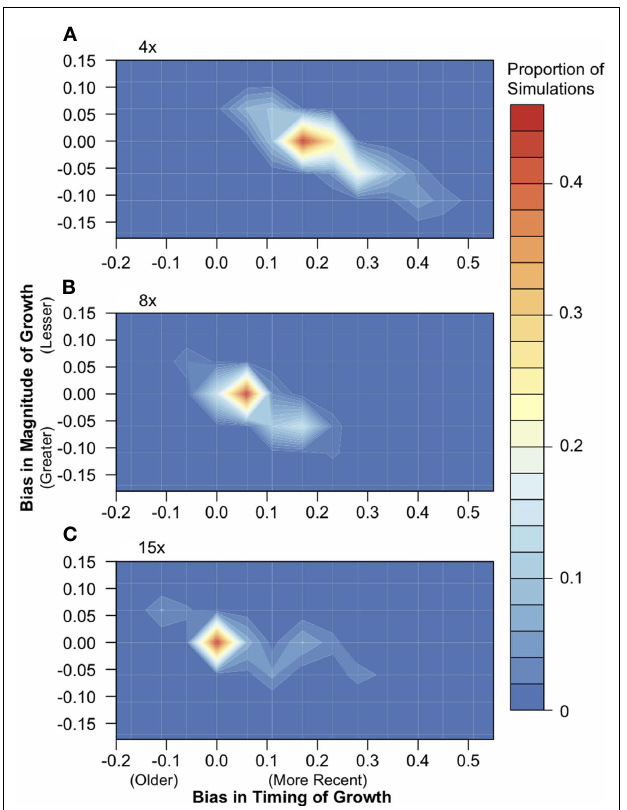
FIGURE 4 |The effect of 4 × , 8 × , and 15 × sequencing on demographic inference. Population samples of 30 chromosomes were simulated under a population expansion model ( n = 500), and the timing and magnitude of growth were inferred using a likelihood approach both from full sequence data and after simulated (A) 4 × , (B) 8 × , and (C) 15 × next-generation sequencing.The difference in the timing of growth, or bias, was calculated by subtracting the parameter value inferred post-sequencing from the pre-sequencing inferred value.The same calculation was used for the magnitude of growth. Colors indicate the proportion of simulations in each region of the parameter